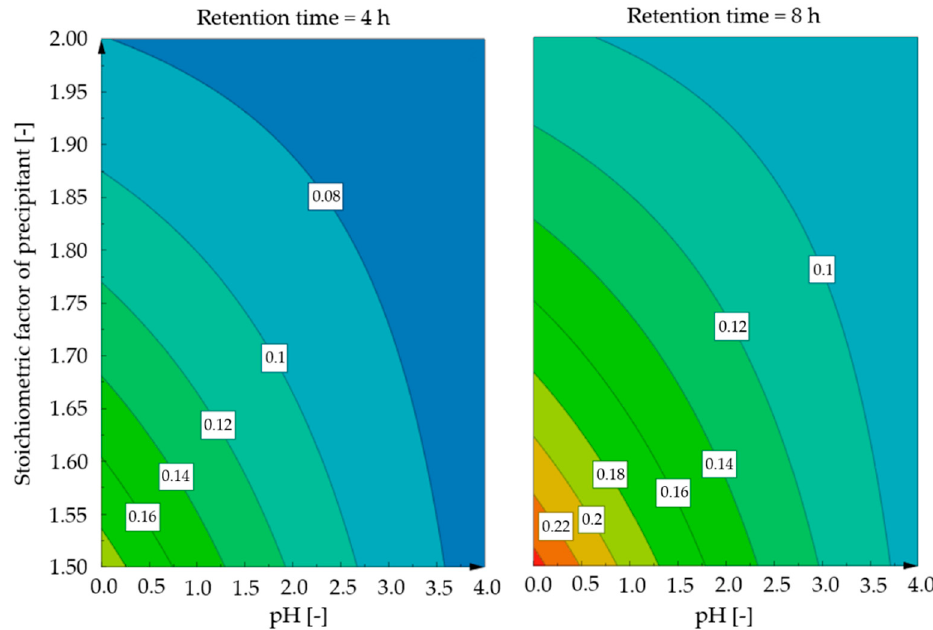
Figure 8. Statistical evaluation of the residual dissolved concentrations (g / L) of cobalt for 4 and 8 h retention time, respectively.